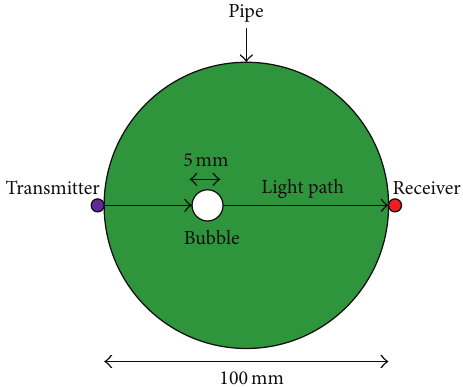
Figure 2: The condition of light path in water with gas bubble presence in contaminated